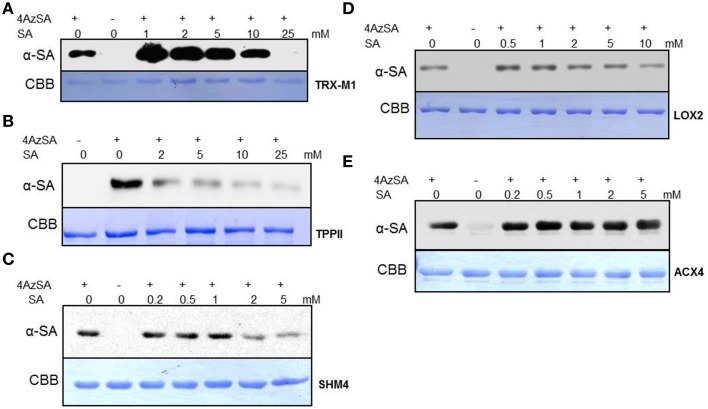
Immuno-blot analyses monitoring SA competition of 4AzSA crosslinking to recombinant cSABPs identified by the 4AzSA/immuno-selection screen. Photo-activated crosslinking of 50 ng/μl of the indicated recombinant purified proteins: (A) TRX-m1, (B) TPPII, (C) SHM4, (D) LOX2, and (E) ACX4 to 4AzSA (50 μM) in the absence or presence of increasing amounts of SA was detected by immuno-blotting using an α-SA antibody. Reactions without 4AzSA served as controls. Note that controls with 4AzSA but without photo-activation were previously shown to give similar results (Tian et al., 2012). Proteins stained with Coomassie brilliant blue (CBB) served as the loading control.